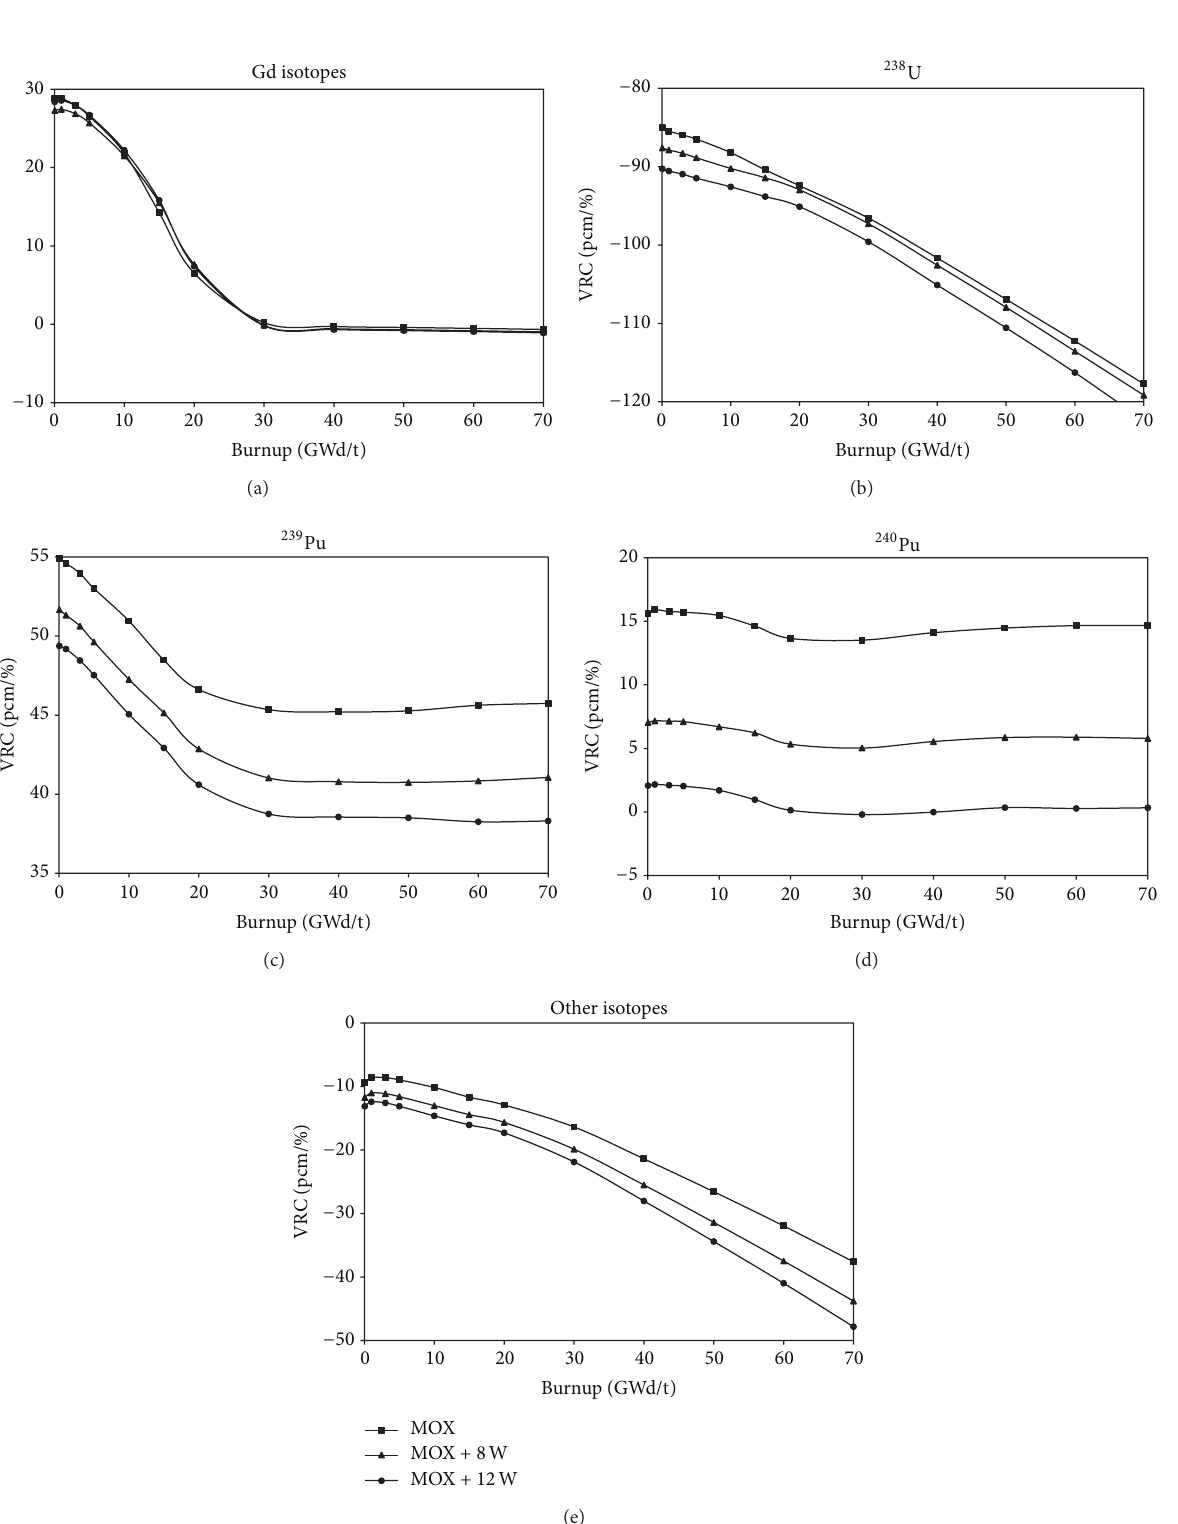
Figure 12: Void reactivity coefficients values for separate isotopes in modified assemblies’